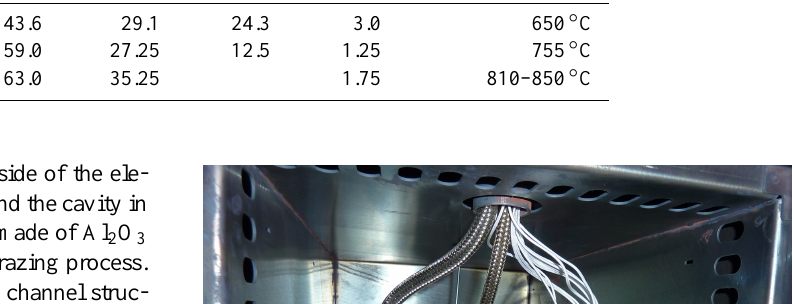
Table 1. Active metal brazing filler metals with their compositions and brazing temperatures. Brazing filler metal